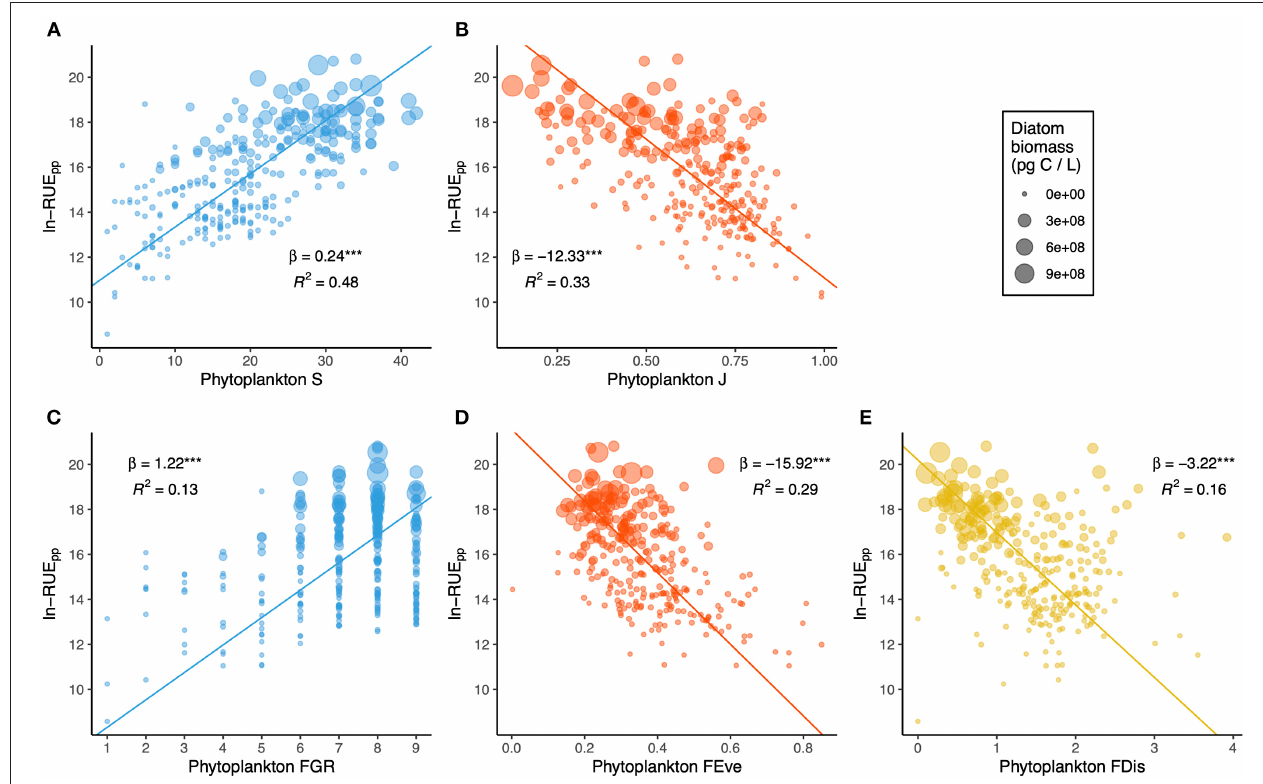
FIGURE 4 | Bivariate plots showing the effects of phytoplankton taxonomic (A,B) and functional (C–E) diversity on RUE pp . Dot size is scaled to diatom biomass, and lines show reduced major axis (RMA) fits. For each relationship, the slope (and statistical significance with parametric p -value < 0.0001***) and the explanatory power are